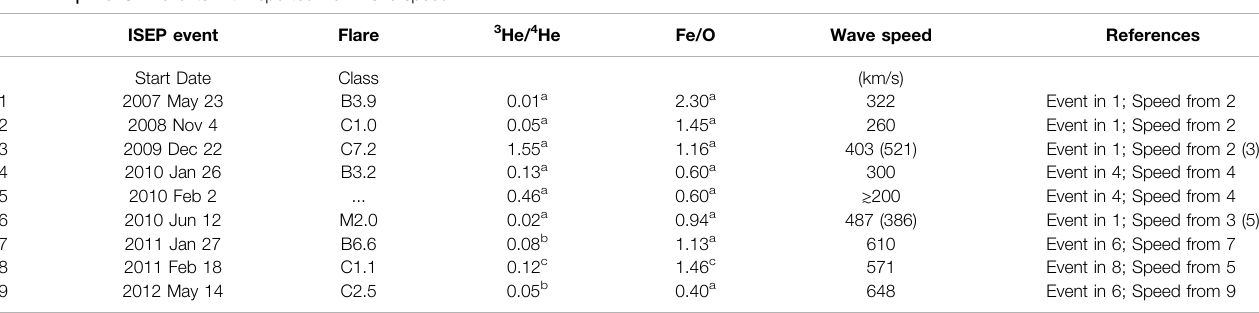
TABLE 1 | The ISEP events with reported EUV wave speed. ISEP event Flare 3 He/ 4 He Fe/O Wave